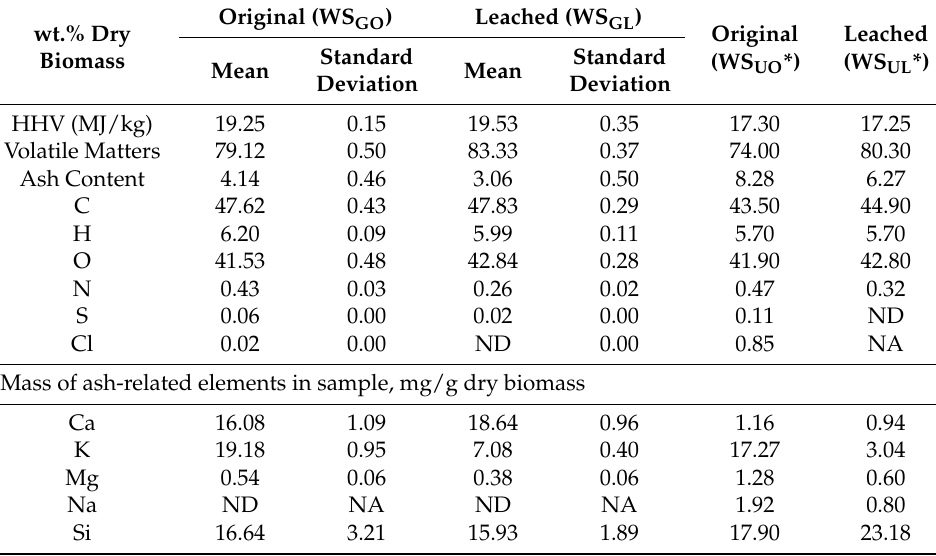
Table 2. Results from the tests of original and leached straw samples. wt.%